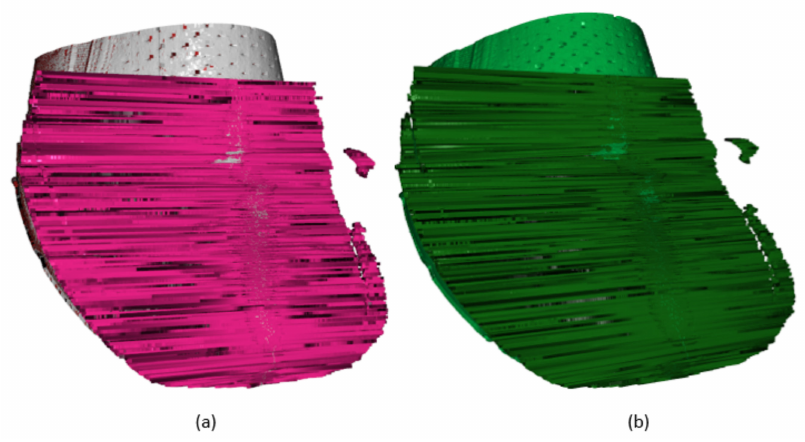
Figure 13. Inspected scan with tangents ( a ) and etalon scan with tangents ( b